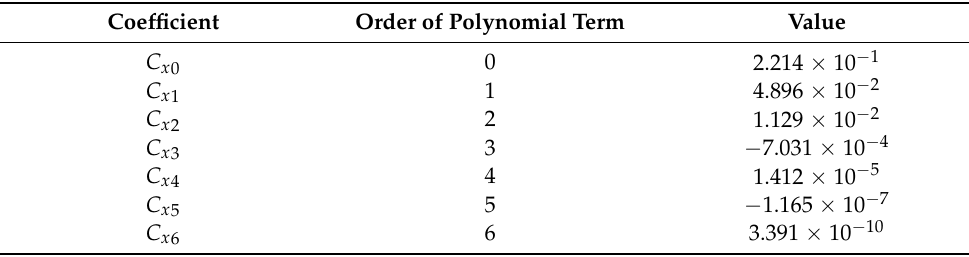
Table 3. The values of C xi of the polynomial X - ∆ ϕ trend line. Coefficient Order of Polynomial